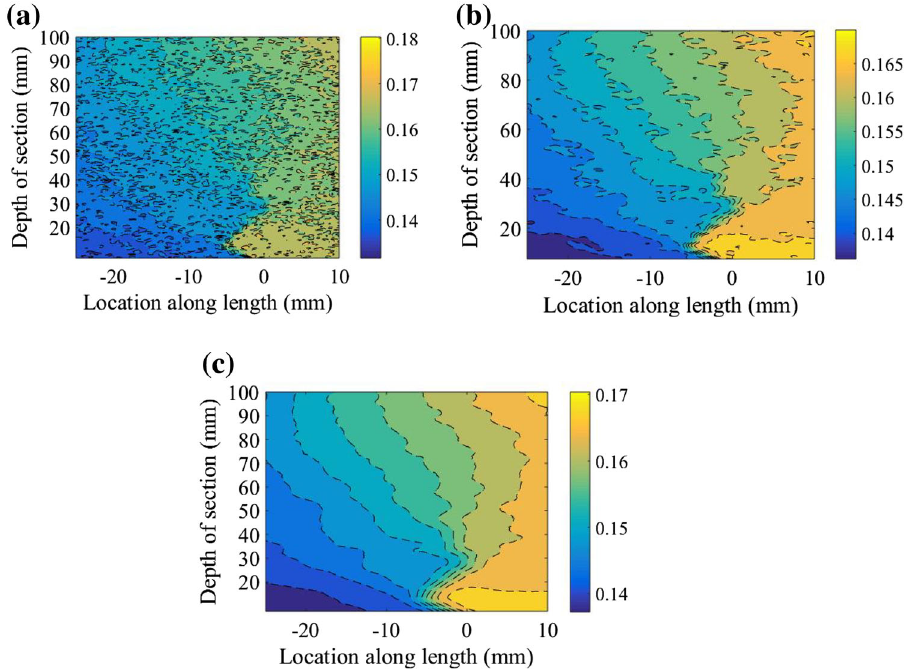
Fig. 4 Contours of U x at CMOD = 0.037 mm corresponding to different subset sizes: a subset size of 15 9 15 pixels; b subset size of 35 9 35 pixels; c subset size of 75 9 75 pixels.